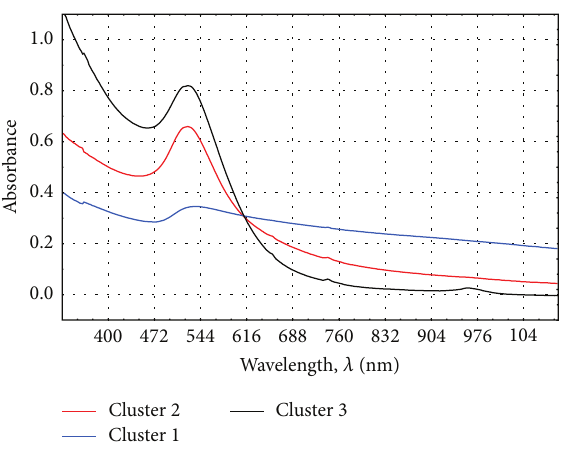
Figure 10: Spectrophotometric spectra of nanogold suspensions obtained based on dog rose extract.